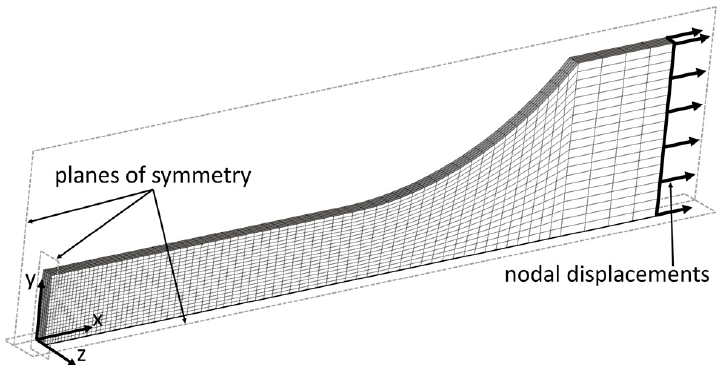
Figure 7. Finite element mesh and boundary conditions used for the numerical model.